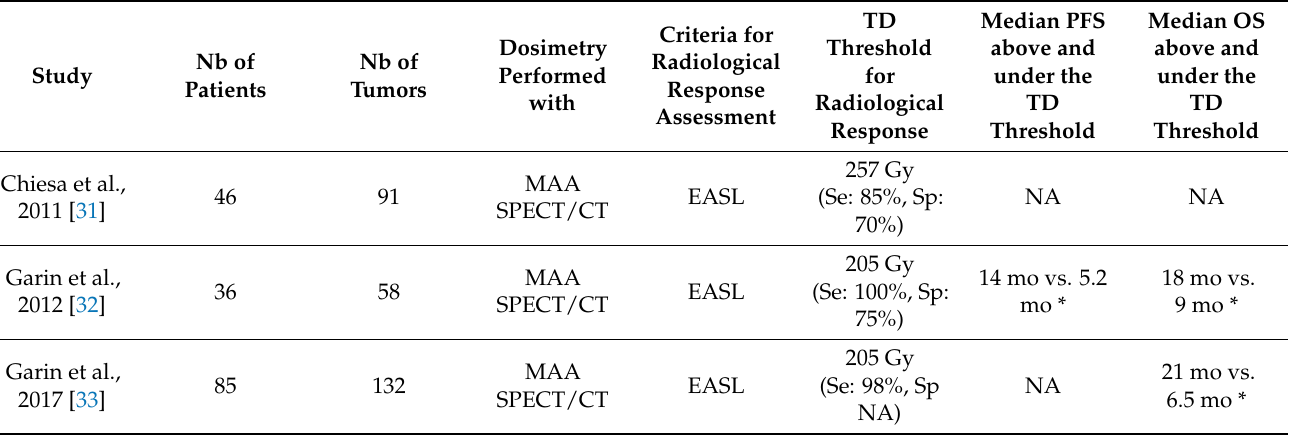
Table 2. Main studies reporting a correlation between tumor dosimetry in SIRT and clinical re- sponse.